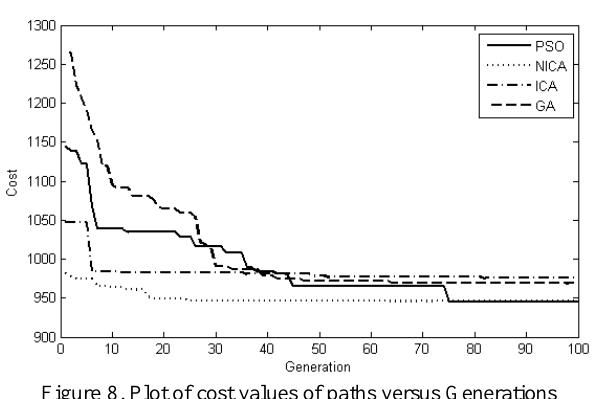
Figure 8. Plot of cost values of paths versus Generations through performance measures.